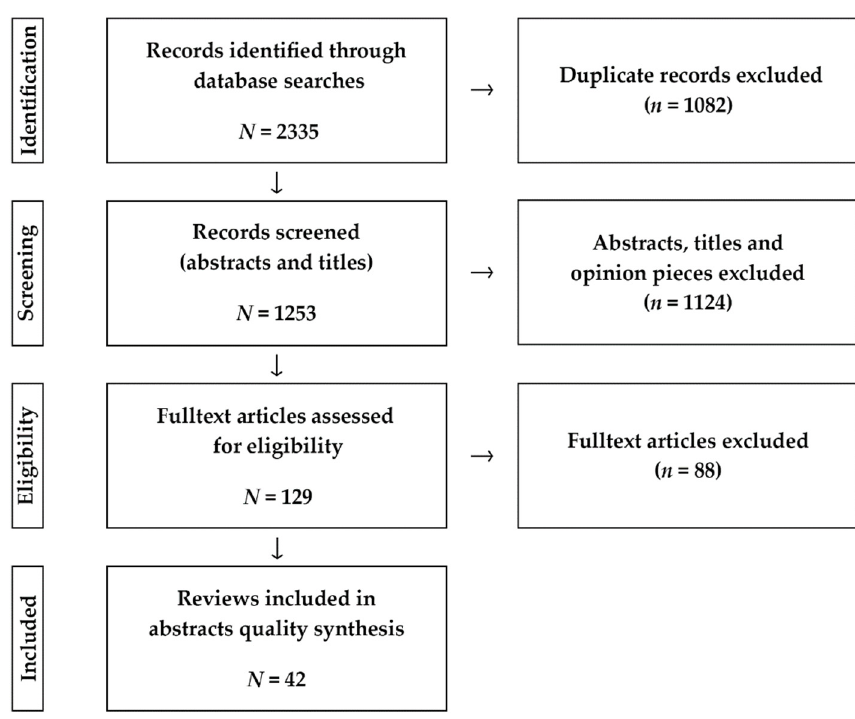
Figure 1. Article selection process.